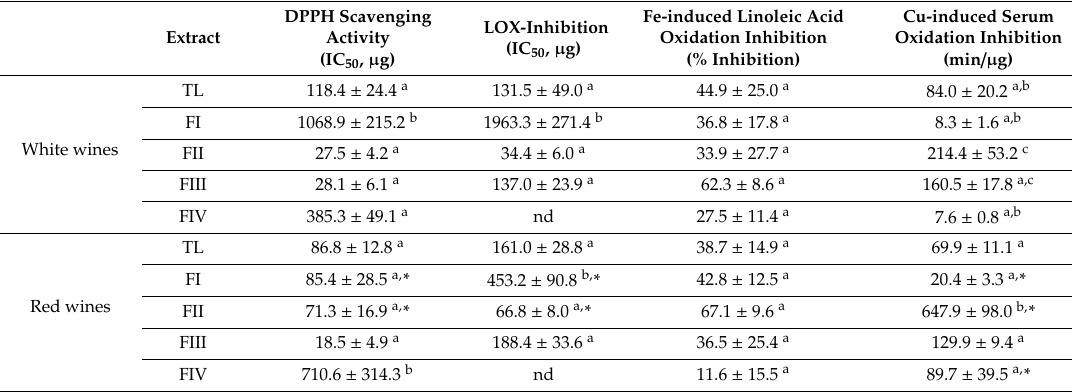
Table 2. Anti-oxidant activity of wines per extract type and per wine